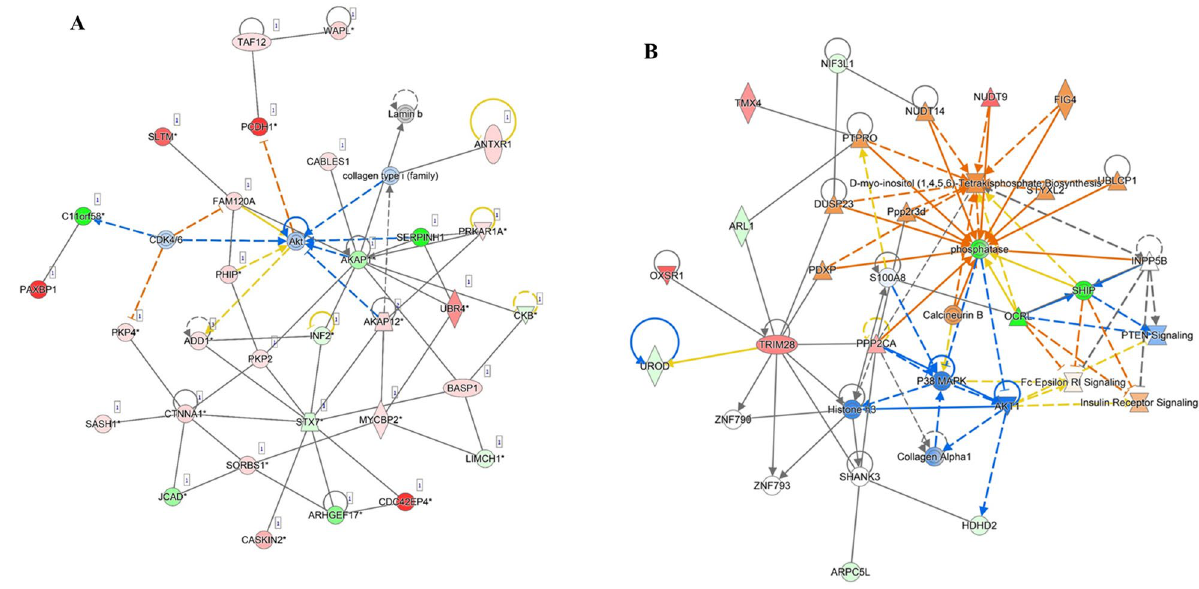
Figure 7. Network analysis of phosphoproteomics ( A ) and proteomics ( B ) of insulin-stimulated adipose tissue reveals the main role of Akt signaling following peripartum dietary ALA supplementation in postpartum dairy cows. Dairy cows were fed; (i) CTL—encapsulated saturated fat, (ii) ALA—flaxseed supplement providing α-linolenic acid (ALA). n = 5 per treatment. The upregulated phosphopeptides or proteins are represented in red, whereas green indicates downregulation. Full lines represent direct interaction, whereas dotted lines represent indirect